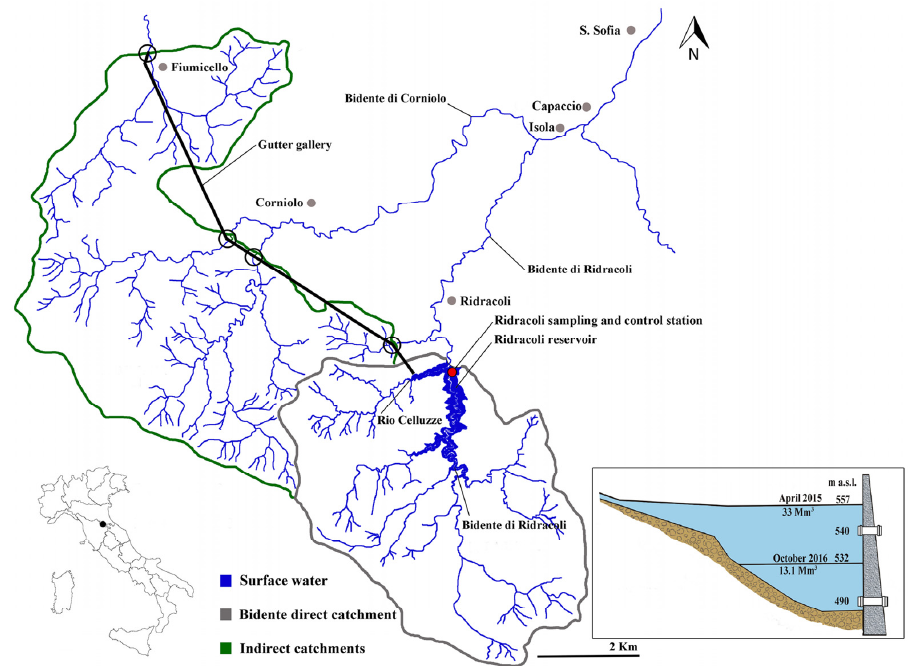
Figure 1. The Ridracoli water reservoir showing the main hydrography, direct and indirect reservoir catchments. Shown are also the gutter gallery (black line), Isola and Capaccio, where the water treatment plant and water analysis laboratory are located, respectively. In the small rectangular a sketch of the reservoir showing the two water intakes at 490 and 540 m a.s.l. and the maximum and minimum water level.